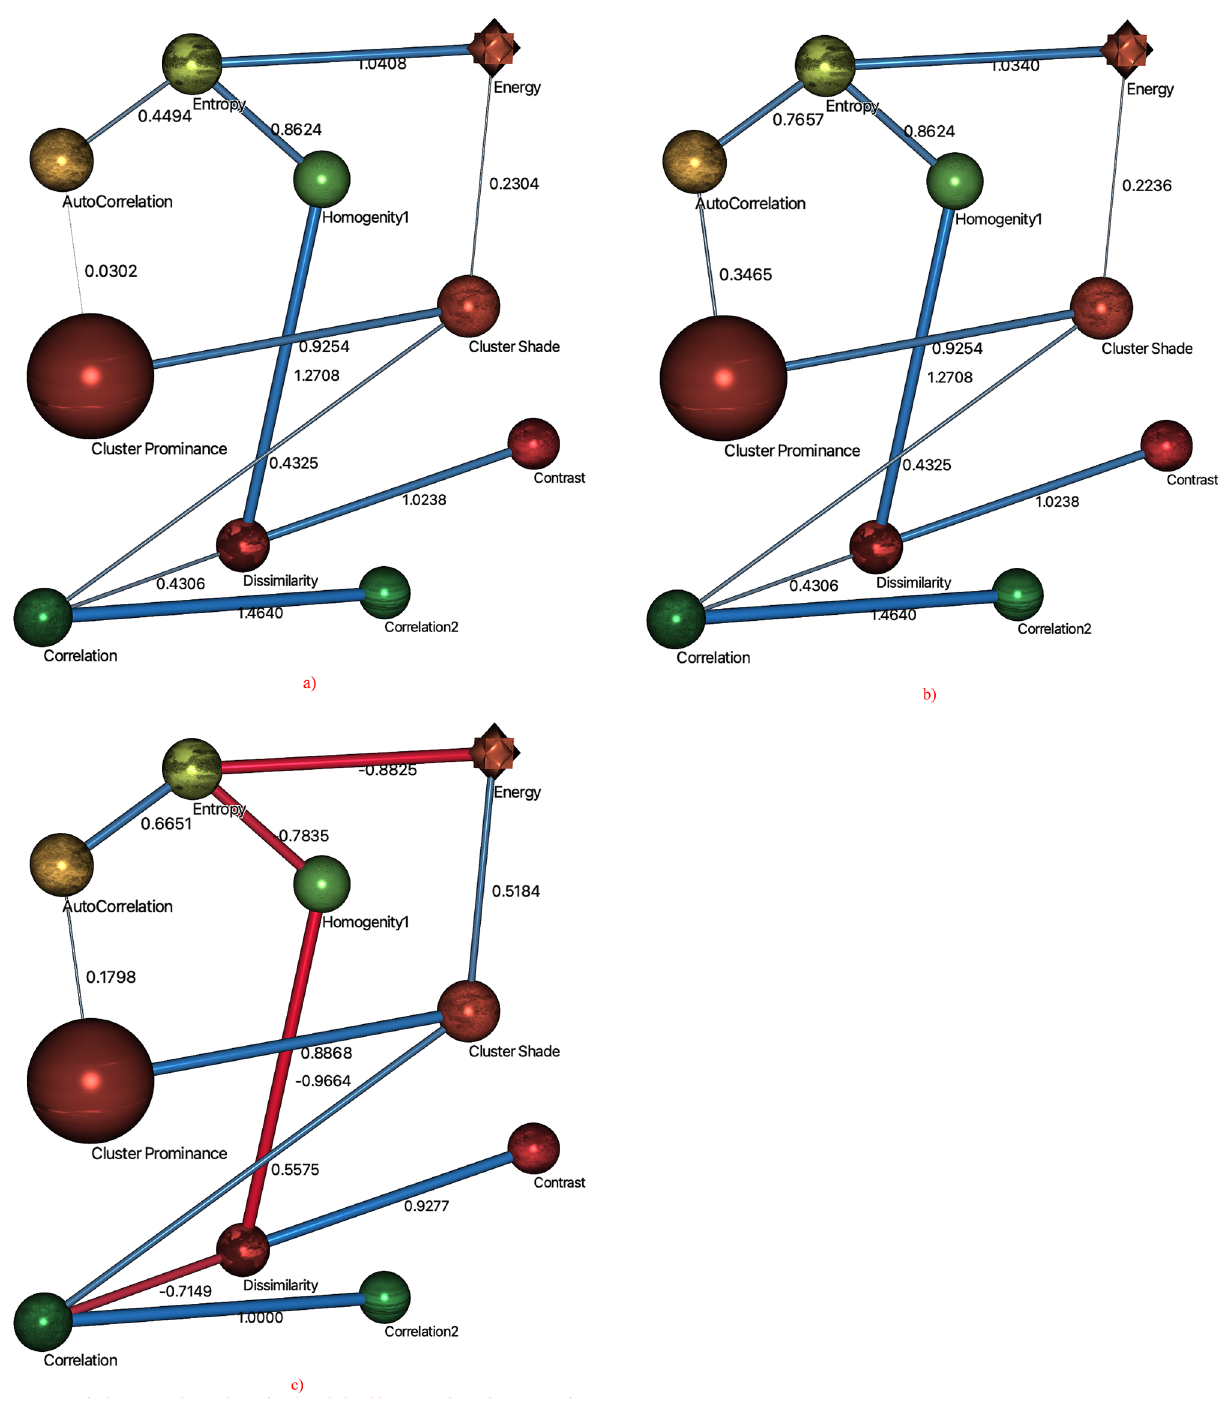
Figure 4. Arc analysis 3D mapping to determine the relationship among the nodes ( a ) mutual information, ( b ) Kullback–Leibler (KL) divergence, ( c ) Pearson’s